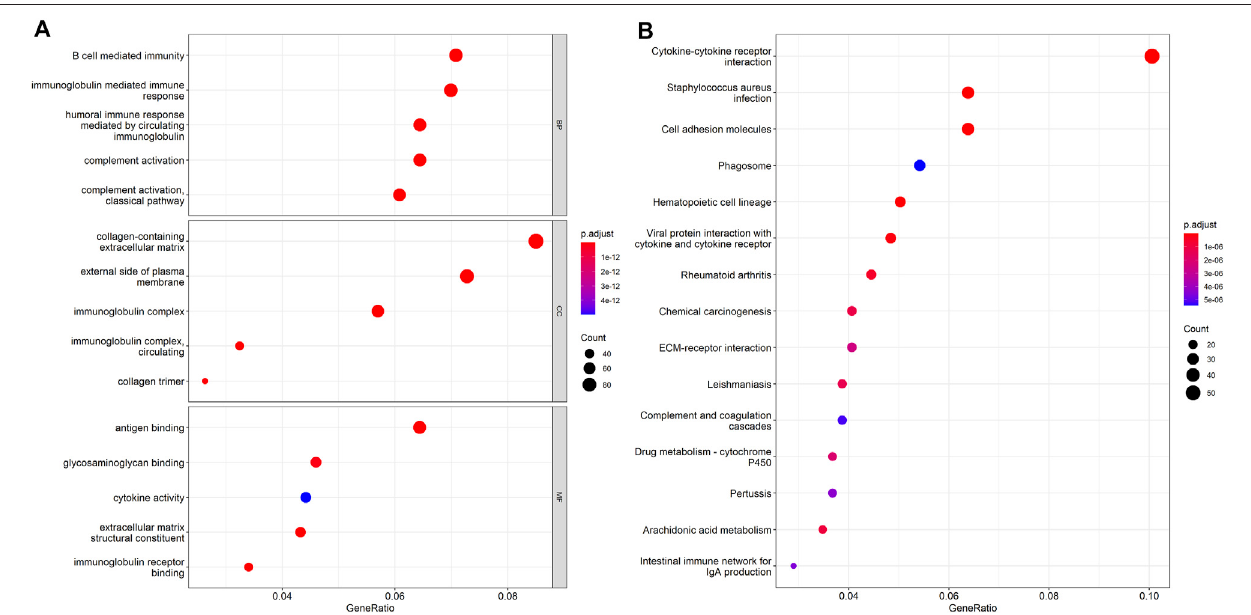
FIGURE 5 | Functional enrichment between the high-risk and low-risk groups. (A) GO function annotation. (B) KEGG pathway